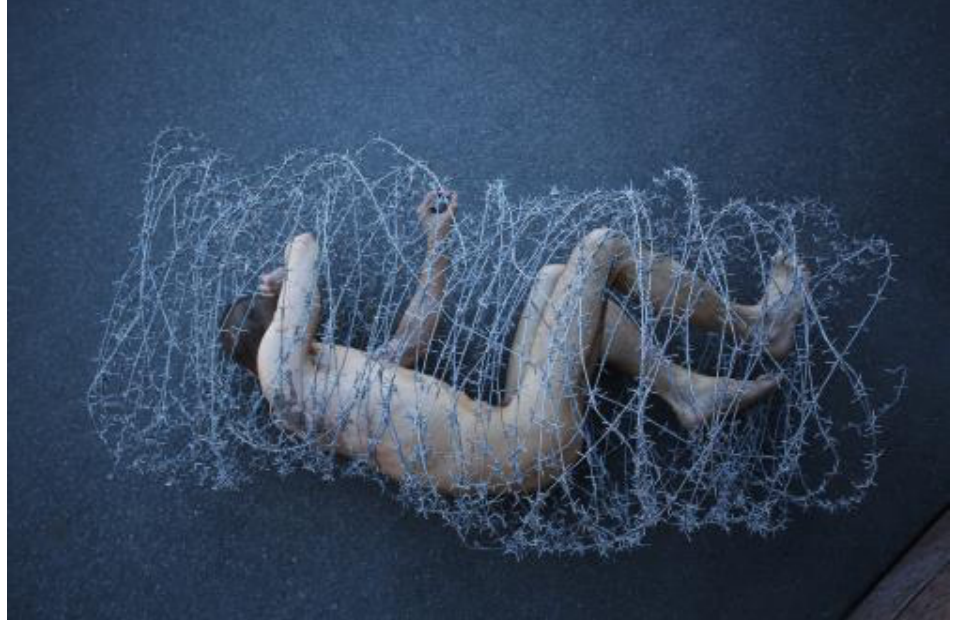
Petr Pavlensky, Carcass ( Туша ), May 3, 2013. Performance action with photographic documentation,